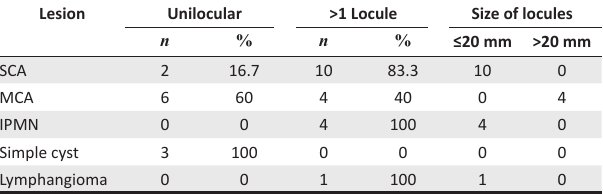
TABLE 4: Loculation pattern and size of pancreatic cystic lesions. Lesion